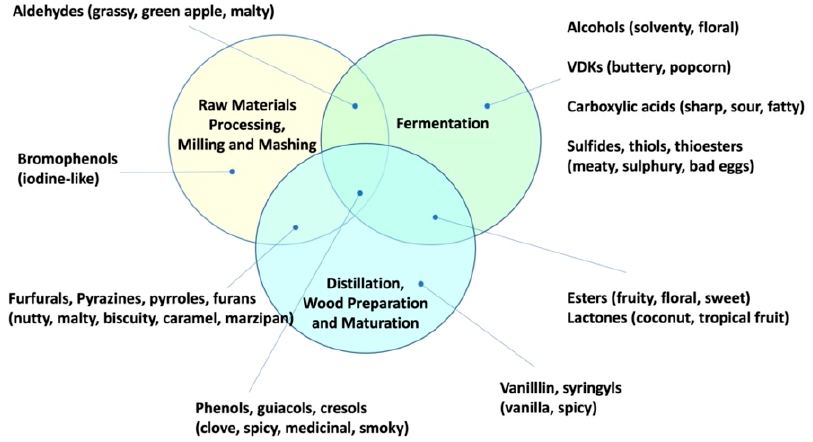
Figure 1. Congeners categorized by Scotch whisky production stage (VDKs: Vicinal Diketones) [1].